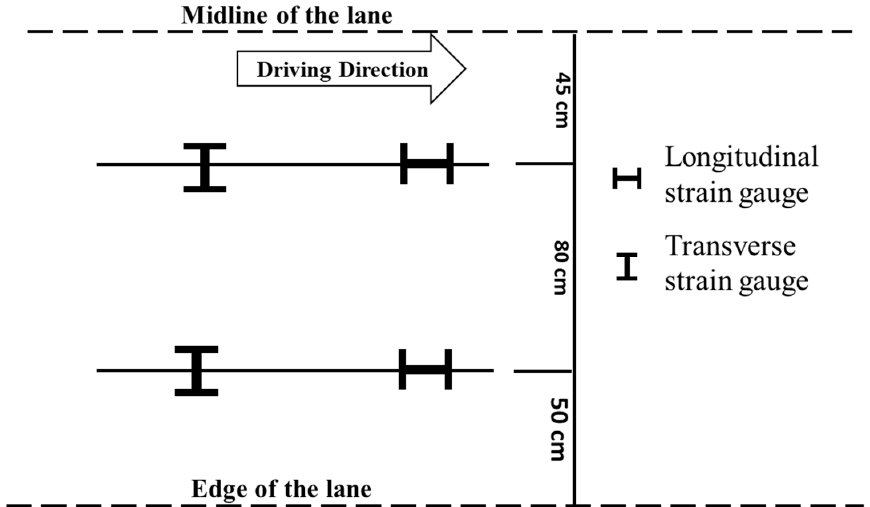
Figure 1. Strain gauge